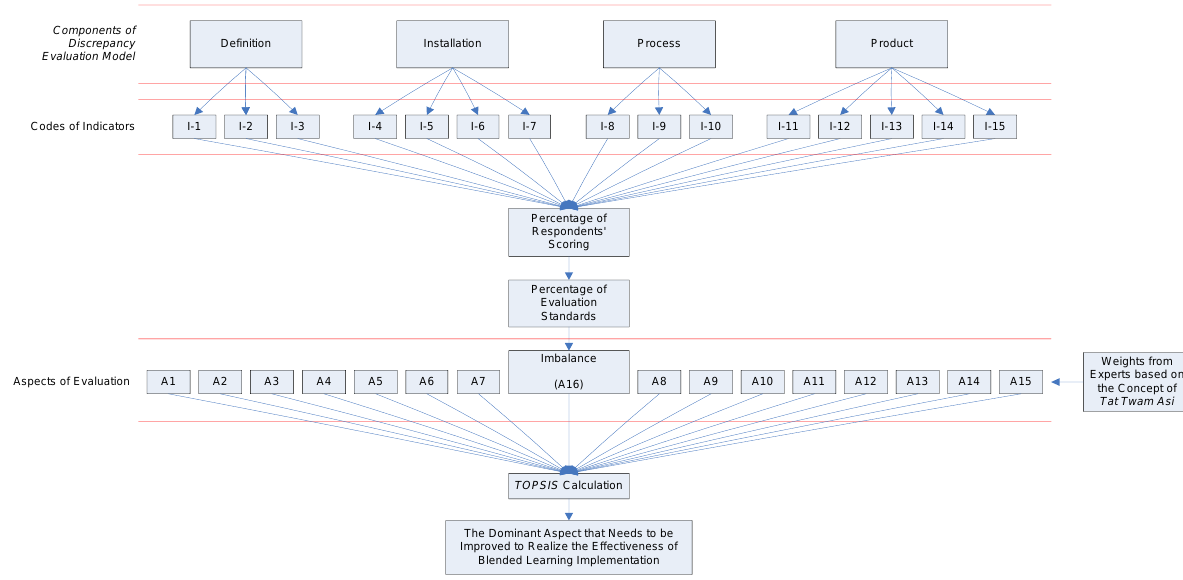
Figure 1. Design of Discrepancy evaluation model that modified by the Tat Twam Asi and TOPSIS.